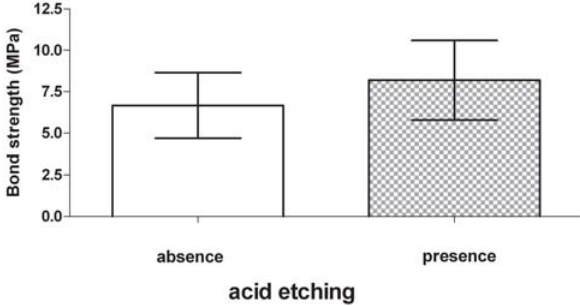
FIGURE 2- Shear bond strength means (MPa) and standard deviation by type of acid etching (presence and